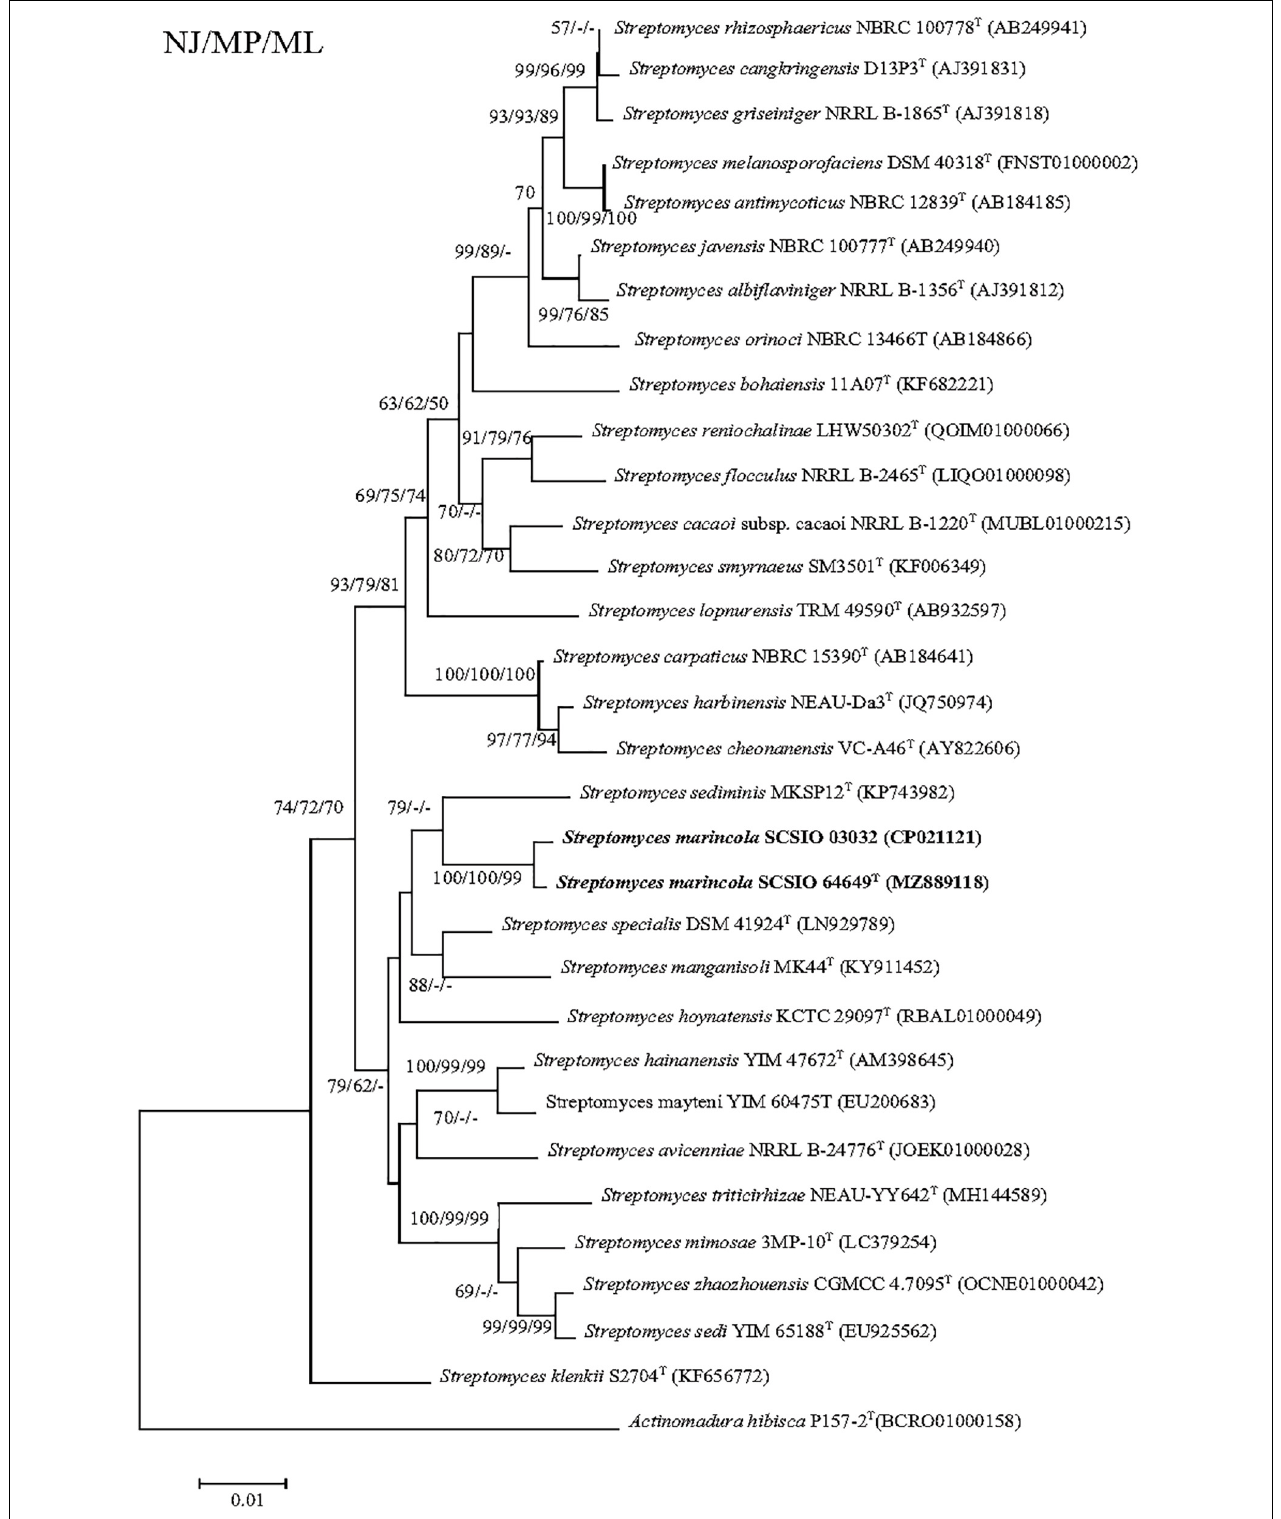
FIGURE 1 | Neighbor-joining tree showing phylogenetic relationships between strains SCSIO 64649 T , SCSIO 03032, and related Streptomyces species, based on 16S rRNA gene sequences. Allostreptomyces psammosilenae YIM DR4008 T (KX689228) was added as an outgroup. Bootstrap values are shown from left to right for neighbor-joining, maximum-likelihood, and maximum-parsimony trees based on 1,000 replications. Bar, 0.01 sequence divergence.